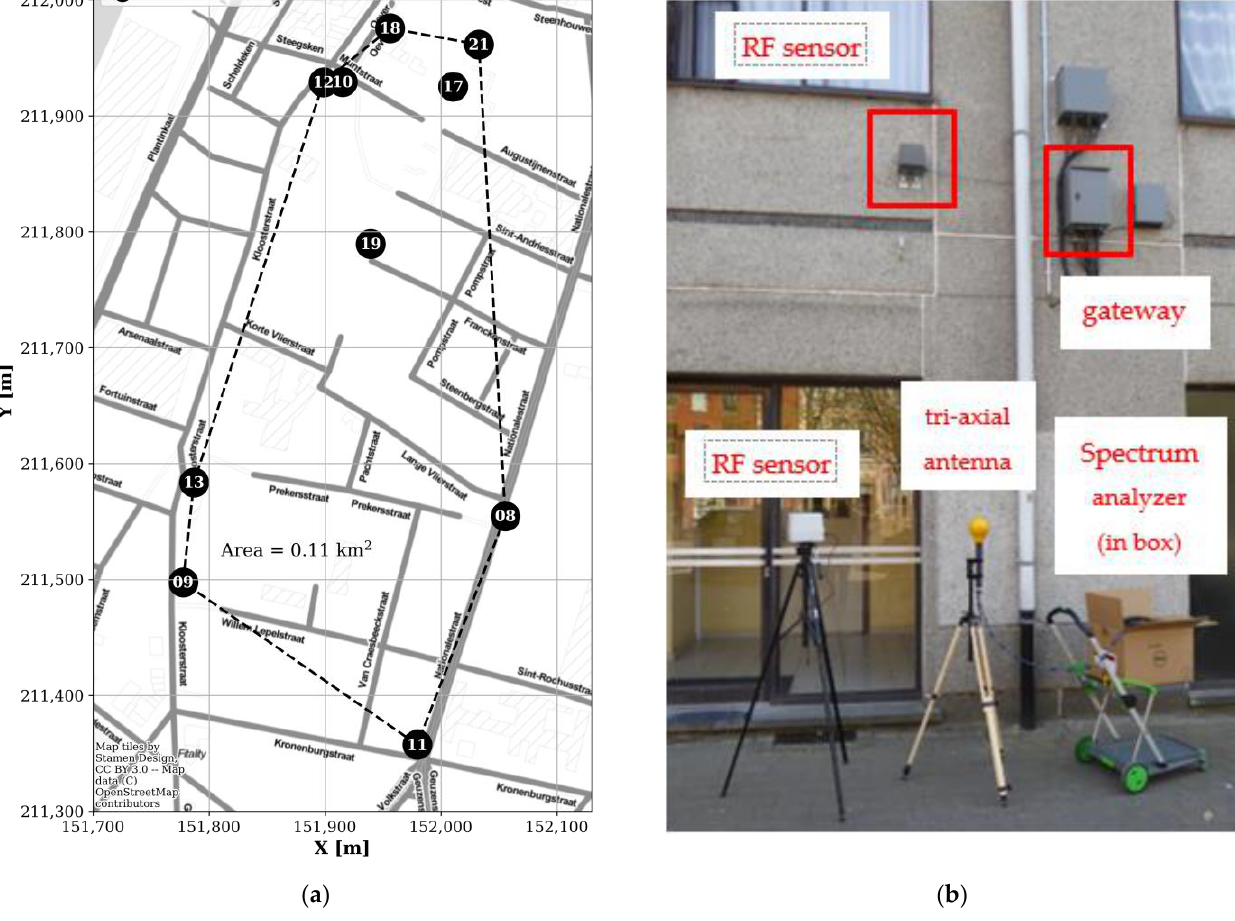
Figure 2. ( a ) Locations of the fixed RF-EMF sensor nodes (labelled with their ID number) in an area of 0.11 km 2 in the IMEC City of Things SmartZone in Antwerp, Belgium (coordinate system: Belgian Lambert 1972). ( b ) Fixed RF-EMF sensor node and gateway mounted on a building façade, and the in situ validation setup (see Appendix B) consisting of an additional RF sensor node (EMF20) and a spectrum analyser and tri-axial antenna at ground level.